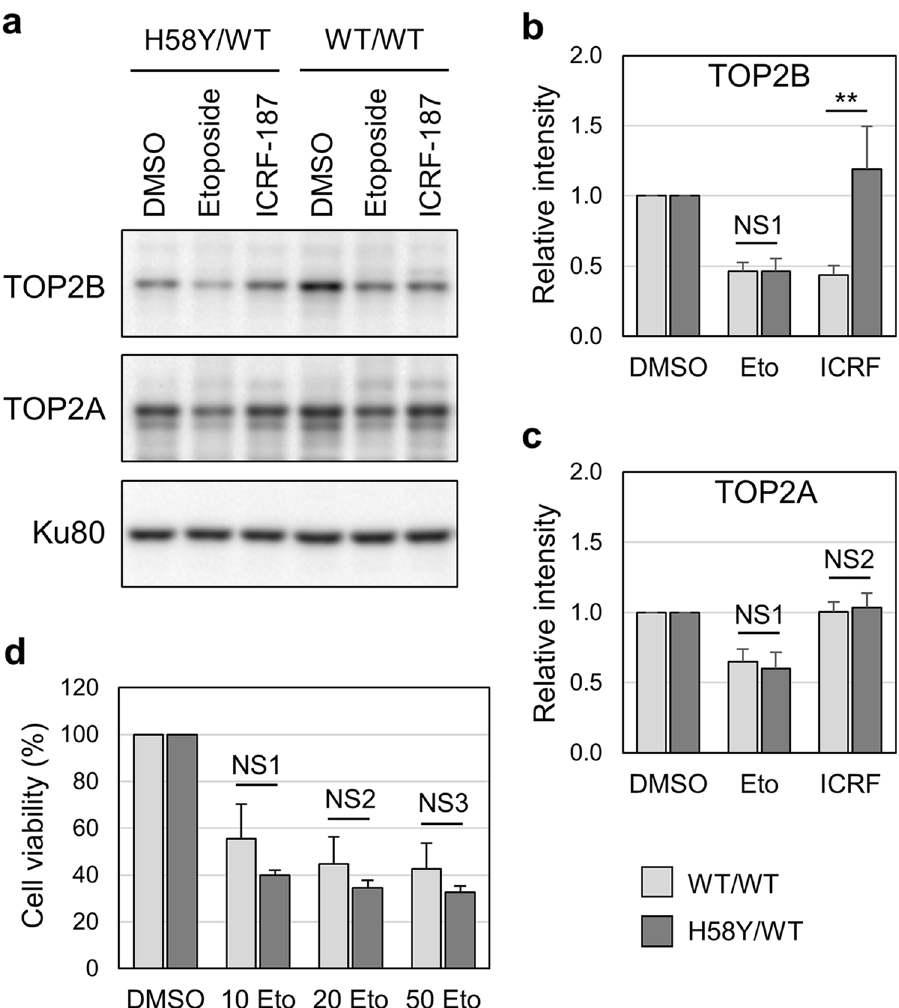
Figure 6. Effects of ICRF-187 and etoposide on TOP2B in H58Y/WT and WT/WT cells. ( a ) Western blot analysis of H58Y/WT and WT/WT cells. Cells were treated with either DMSO, 100 µM etoposide, or 20 µM ICRF-187 for 2 h. TOP2B and TOP2A were analyzed by Western blotting. Ku80 was shown as a loading control. Original uncropped images are shown in Supplementary Fig. S4. ( b ) Quantification of Western blot signals of TOP2B. Experiments were repeated 3 times as described in ( a ). Original uncropped images are shown in Supplementary Fig. S4. Values of DMSO-treated samples were arbitrarily set 1, and average values of relative intensities of western blot bands were calculated (n = 3; bar, SD). Statistical values are as follows; **: statistically significant; p = 0.0457. NS not significant. NS1; p = 0.976. ( c ) Quantification of Western blot signals of TOP2A. Experiments were repeated 3 times as described in ( a ). Original uncropped images are shown in Supplementary Fig. S4. Values of DMSO-treated samples were arbitrarily set 1, and average values of relative intensities of western blot bands were calculated (n = 3; bar, SD). Statistical values are as follows; NS; Not significant. NS1; p = 0.591, NS2; p = 0.664. ( d ) Effects of etoposide on the viabilities of H58Y/WT and WT/WT cells. Cells were treated with either DMSO, 10 µM, 20 µM, or 50 µM etoposide for 2 h. After washing with fresh media, cells were cultured for 3 days. Values of DMSO-treated samples were arbitrarily set to 100%. Average values with SD were calculated from 5 independent experiments. Statistical values are as follows; NS not significant. NS1; p = 0.113, NS2; p = 0.116, NS3; p =